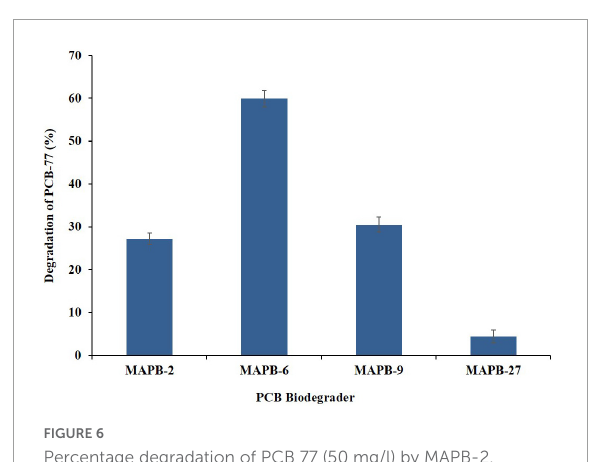
FIGURE6 Percentage degradation of PCB 77 (50 mg/l) by MAPB-2, MAPB-6, MAPB-9, and MAPB-27 kept at 30 ◦ C for 7